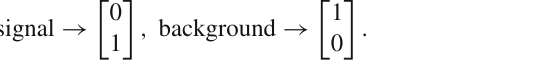
Table 2 The cut flows of the signals and background in boosted region. The events are generated at 1 (cid:4) ± + E / T + jets final state, where (cid:4) denotes e and μ . M i Γ j denotes the benchmark case with M ρ = i TeV and Process Event